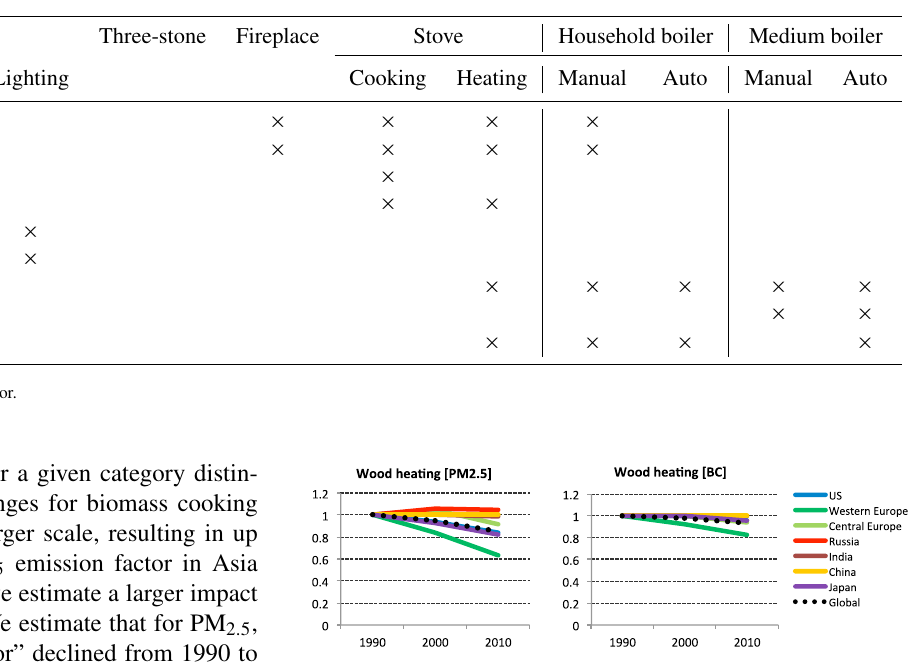
tinguish between wick and hurricane lamps, with the former representing the majority (Lam et al., 2012; Mills, 2005). As a default, we assume 80 % kerosene wick lamps in South Asia and 50 % in other developing world regions. For a dis- cussion of how total activity data for kerosene lighting is cal- culated, see Sect.